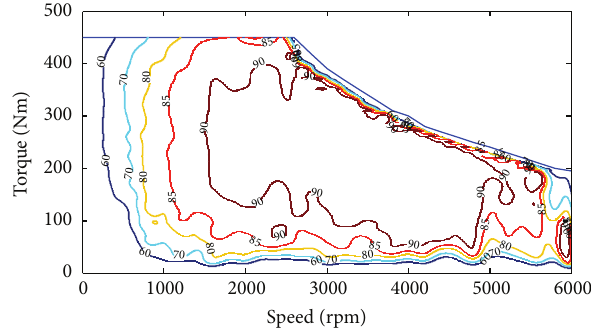
Figure 2: Efficiency map of the electric